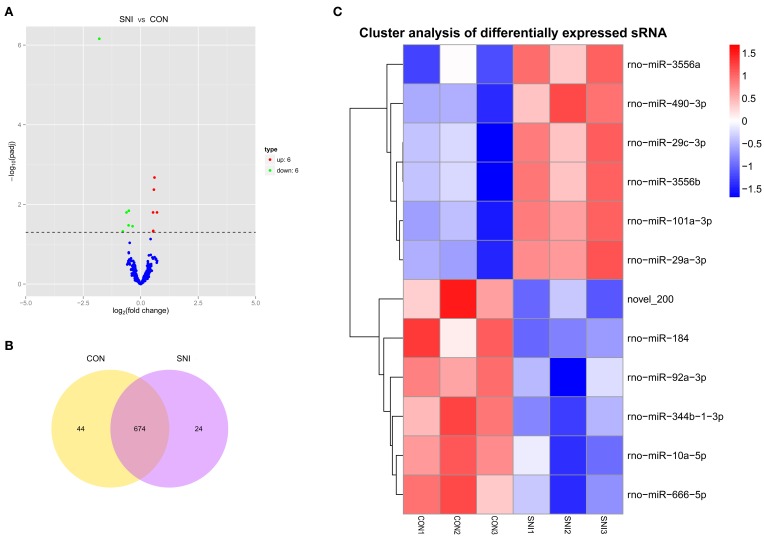
The expression profiling changes of miRNAs in spinal cord of SNI rats Vocalno Plot indicate up and down regulated miRNAs of rats in group SNI compared with group CON (A); Venn diagram showing the number of overlap miRNAs in group SNI compared with group CON (B); Heat map of miRNAs showing hierarchical clustering of changed miRNAs of rats in group SNI compared with group CON. In clustering analysis, up- and down-regulated genes are colored in red and blue, respectively (C).